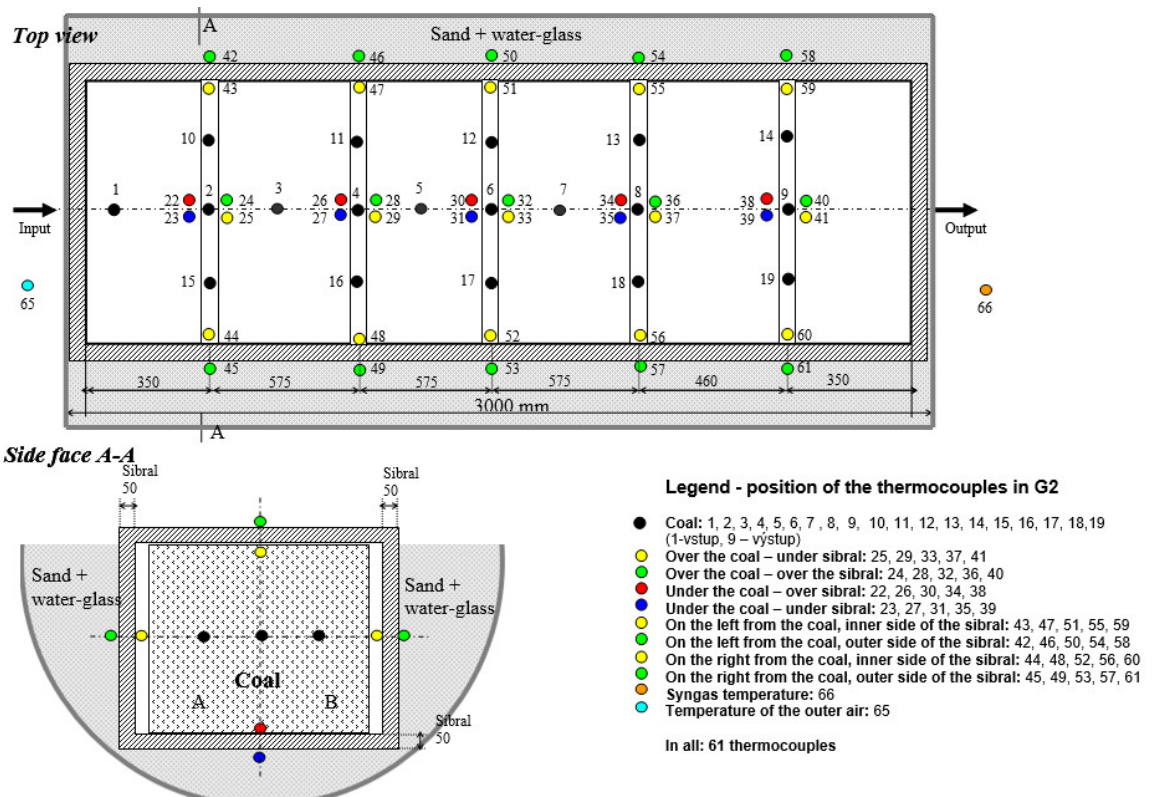
Figure 5. The scheme of the position of the thermocouples in the reactor for the second experiment.